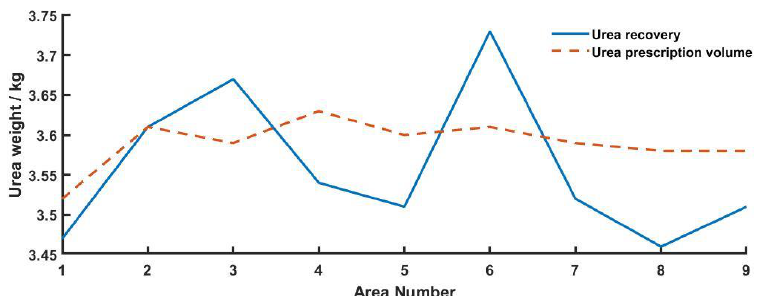
Figure 8. Comparison of the actual spreading amount of granular fertilizer and the spreading amount of the prescription chart. From the effect of the spreading and recovery of agricultural UAV granular fertilizer, the difference between the actual spreading amount of the UAV granular fertilizer and the spreading amount on the prescription map was small. The error value of each plot did not exceed 4.3% and the RMSE between the two was 0.0841. The reason for such a result is due to the joint influence of multiple factors such as the wind field and system delay during the operation of the agricultural UAV spreading system, but the overall difference between the deposition effect and the tracking amount given in the prescription map was not great. The actual fertilizer application is shown in Table 2 and after removing control area 9, the ratio of the total actual fertilizer application to the standard fertilizer applica- tion was calculated. The results yielded a 24.76% reduction in the amount of nitrogen fer- tilizer chasing compared to traditional manual fertilization.